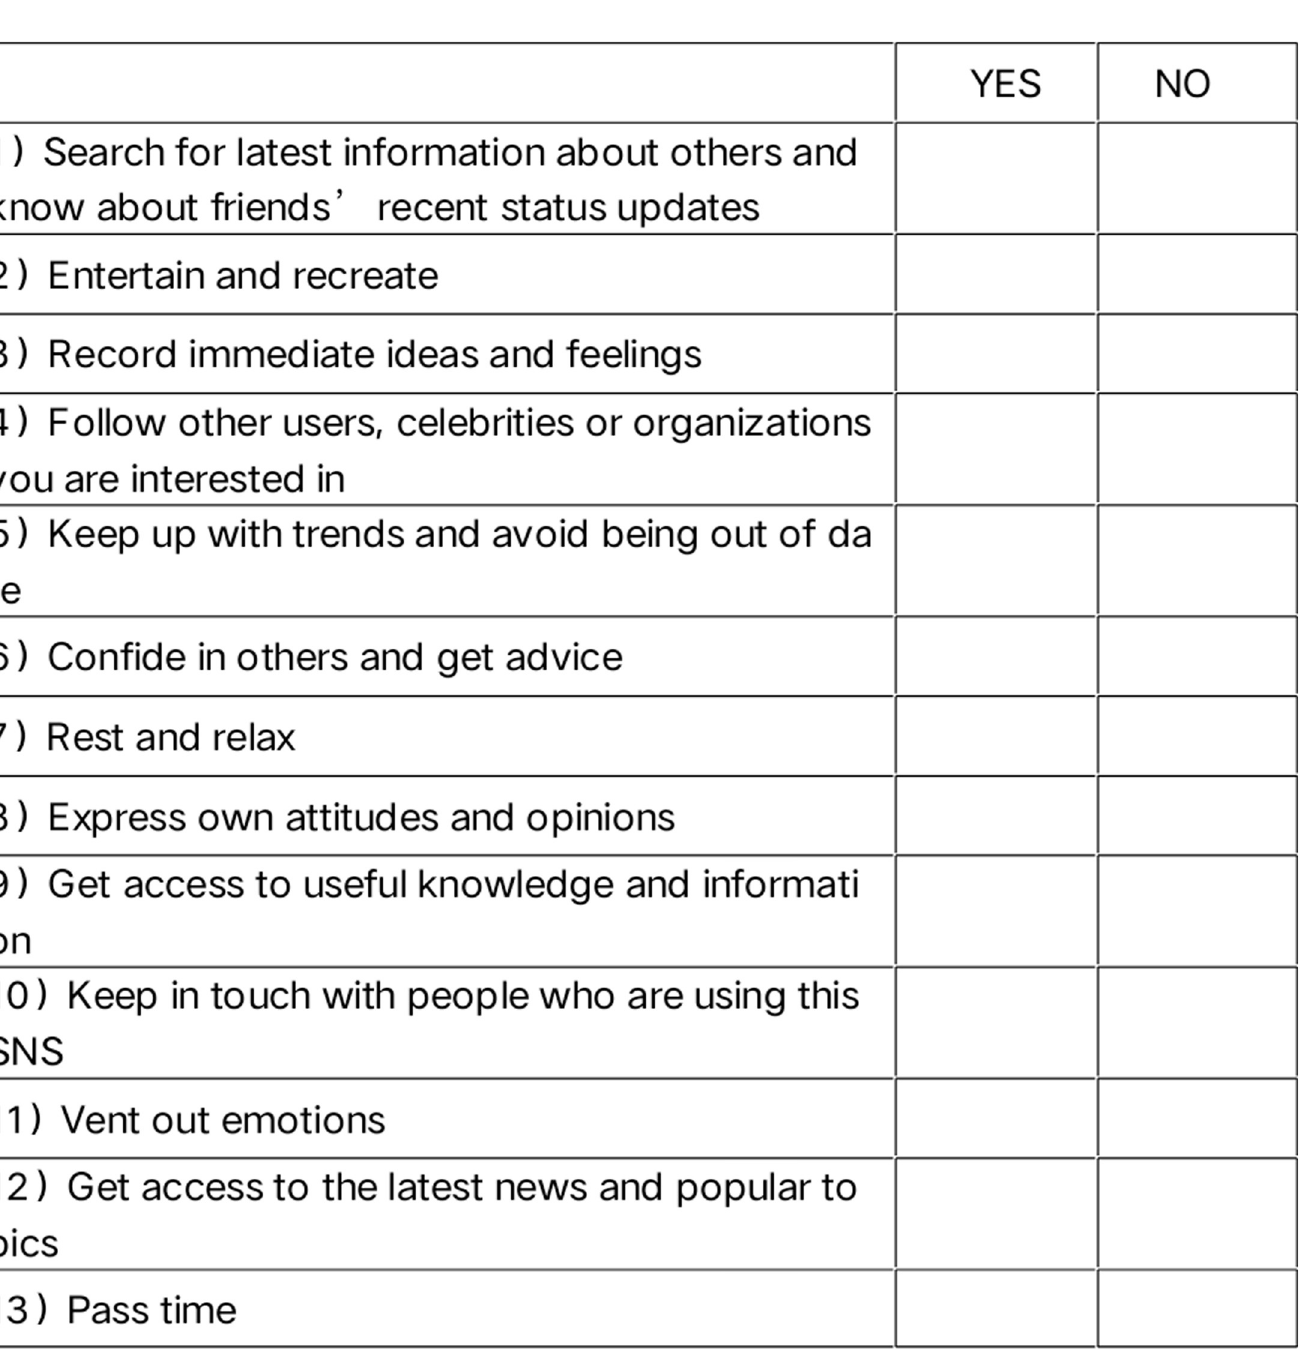
Fourth, we performed a reliability test that showed the internal consistency (Cronbach’s α coefficient) of the 14 images was 0.938. The reliability test of the initial questionnaire showed that the score of the questionnaire was 0.857, and the internal consistency (Cronbach’s α coef- ficient) of the four subtests of emotional motivation, cognitive motivation, leisure motivation and herd motivation were 0.899, 0.851, 0.890, 0.839 respectively.